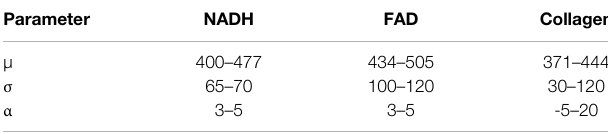
TABLE 1 | Ranges of parameters used in the skew normal functions to produce fl uorescence emission spectrum. Parameter NADH